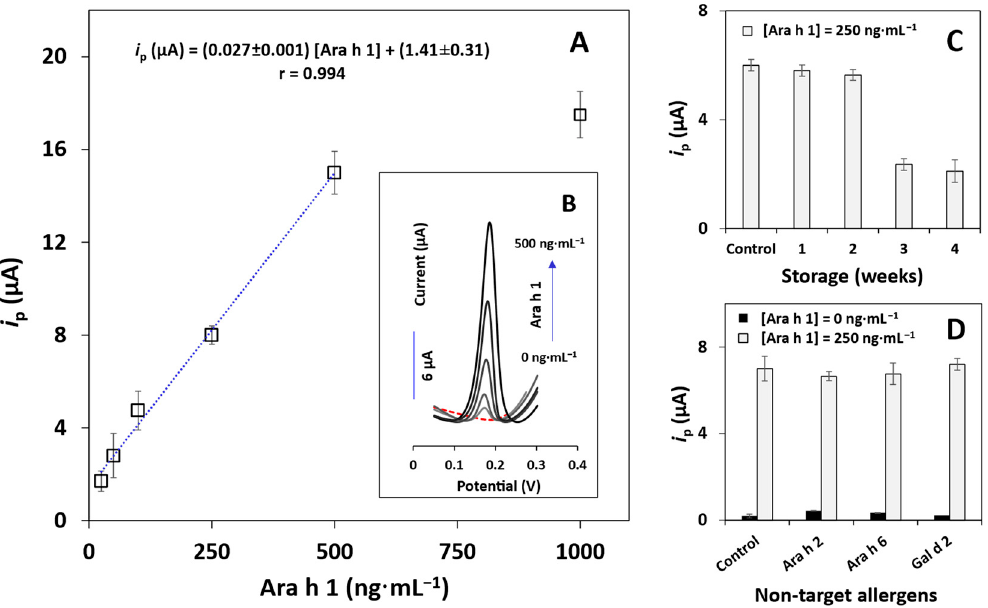
Figure 3. ( A ) Calibration plot for the analysis of Ara h 1 ( i p vs. Ara h 1 concentration) using the SPCE/ND immunosensor. ( B ) Representative linear sweep voltammograms of [Ara h 1]: 0, 25, 50, 100, 250 and 500 ng·mL − 1 ). ( C ) Storage stability of the sensor (Ara h 1: 250 ng·mL − 1 ) after 1 day (control) and for 4 weeks. ( D ) Selectivity and interference studies (Ara h 1 (0 and 250 ng·mL − 1 ), non-target allergens: Ara h 2 (250 ng·mL − 1 ), Ara h 6 (5.0 ng·mL − 1 ), Gal d 2 (180 mg·mL − 1 )). Other conditions: CAb: 10 µg·mL − 1 , DAb: 250×, S-AP: 200,000×, 3-IP/Ag + : 1.0 × 10 − 3 M/4.0 × 10 − 4 M. LSV parameters: potential range from − 0.03 V to +0.4 V, scan rate: 50 mV·s − 1 . Error bars are the standard deviations of three replicates.